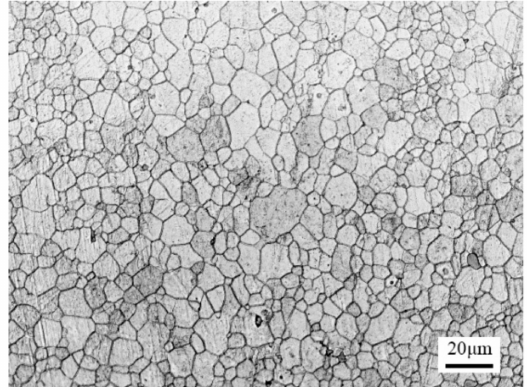
Figure 1. Microstructure of as-received AZ31B